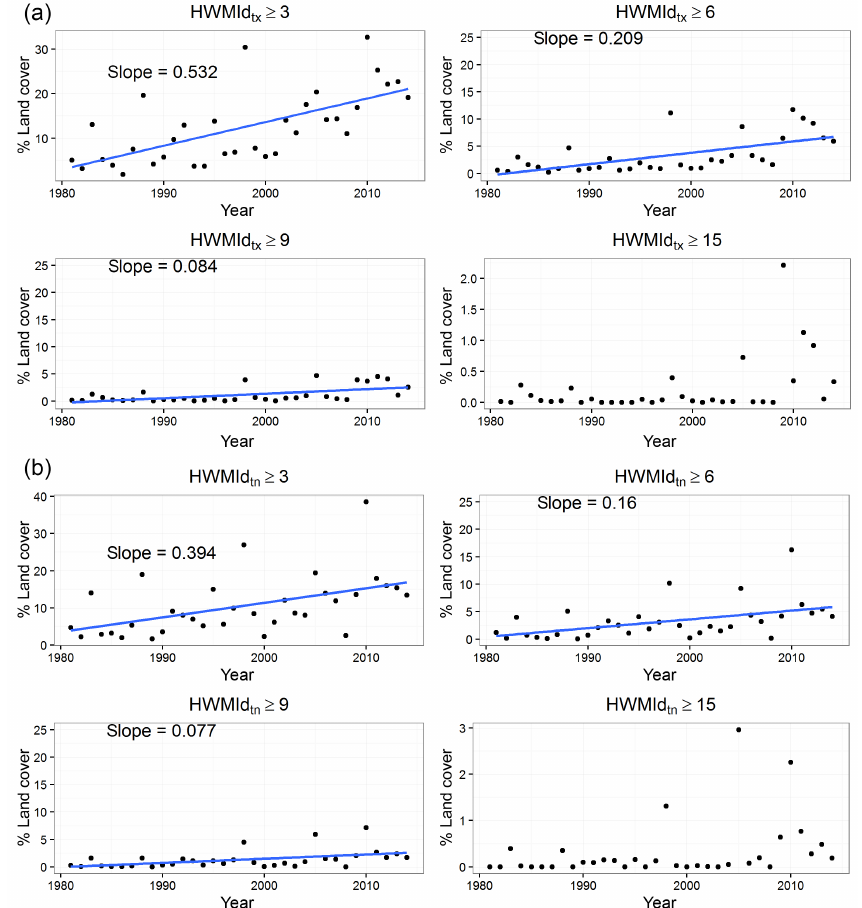
Figure 6. Annual distribution of events exceeding four different thresholds (i.e. HWMId ≥ 3, 6, 9, 15) for maximum (top panel) and minimum (bottom panel) temperature. Since the reanalysis-based HWMId is a gridded product, plots show the percentage of land area affected by heat waves rather than the number of